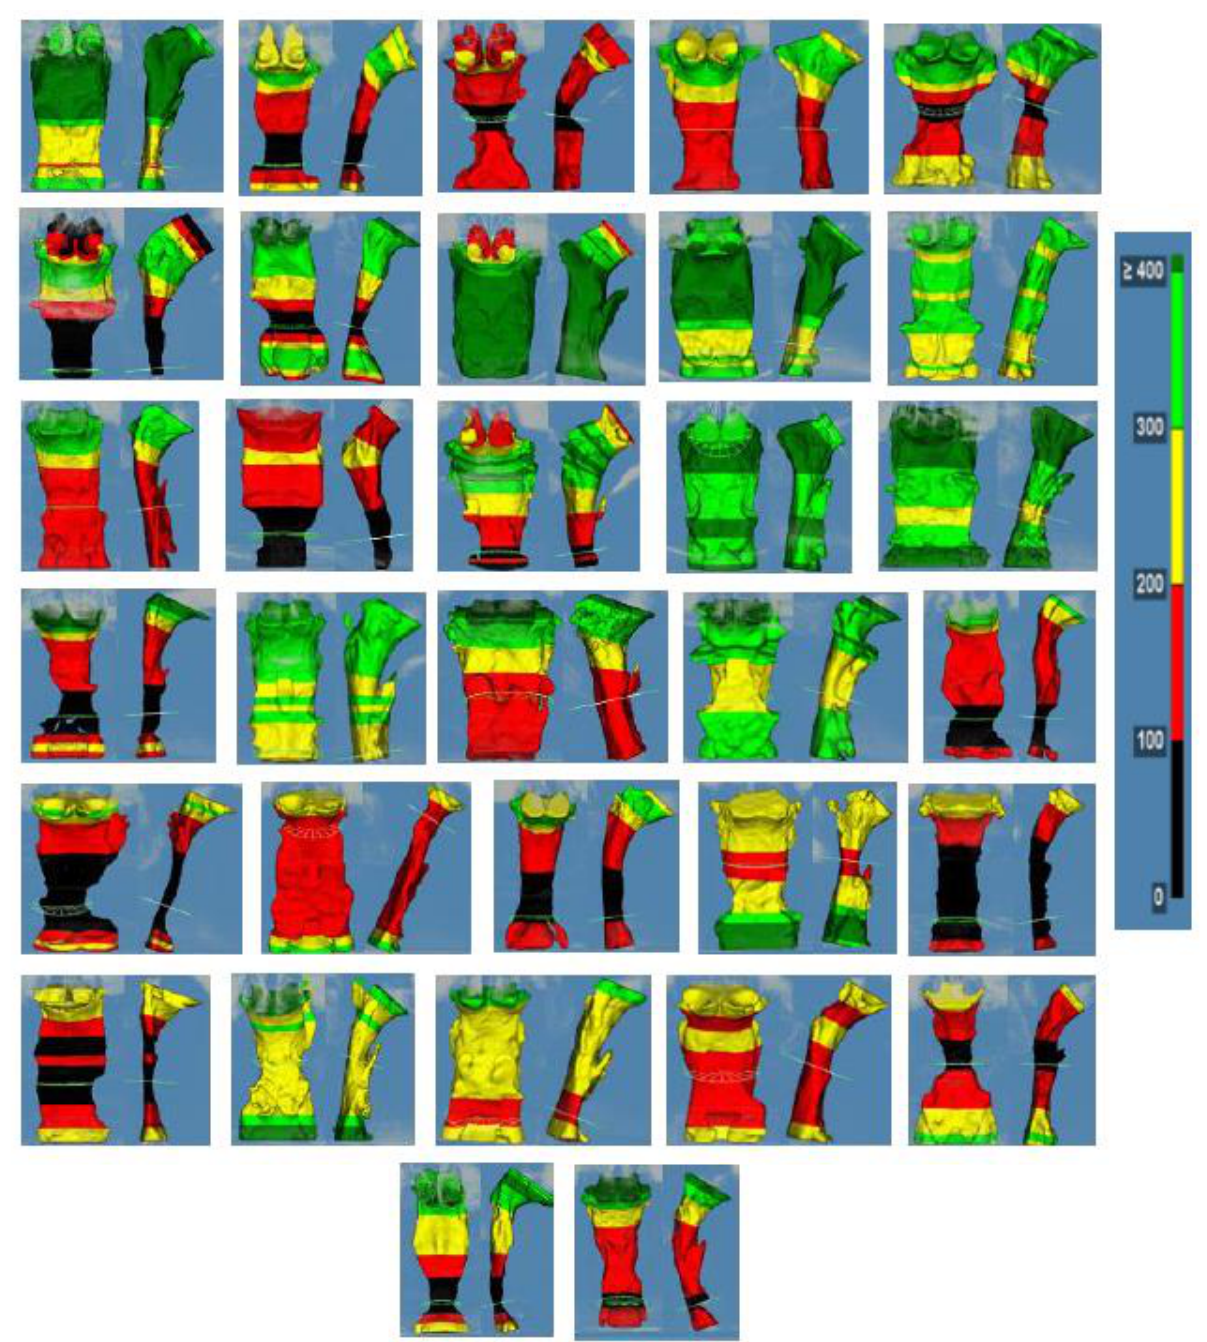
Figure 3. Frontal and sagittal views of the airways of all JIA patients with the scale measured in square millimeters of airway cross-section and a marker showing the level of the minimal cross- sectional area of each. Please note that visualizing the color map of the airway utilizes a different feature of Dolphin Imaging, which does not allow for as much precision in setting the upper and lower airway boundaries and is only used here to give a visual representation of the cross-sectional areas at different levels of the airway. All quantitative volumetric and minimal cross-sectional data were gathered with the segmentation boundaries set, as described in Section 2 and as shown in Figure 2.